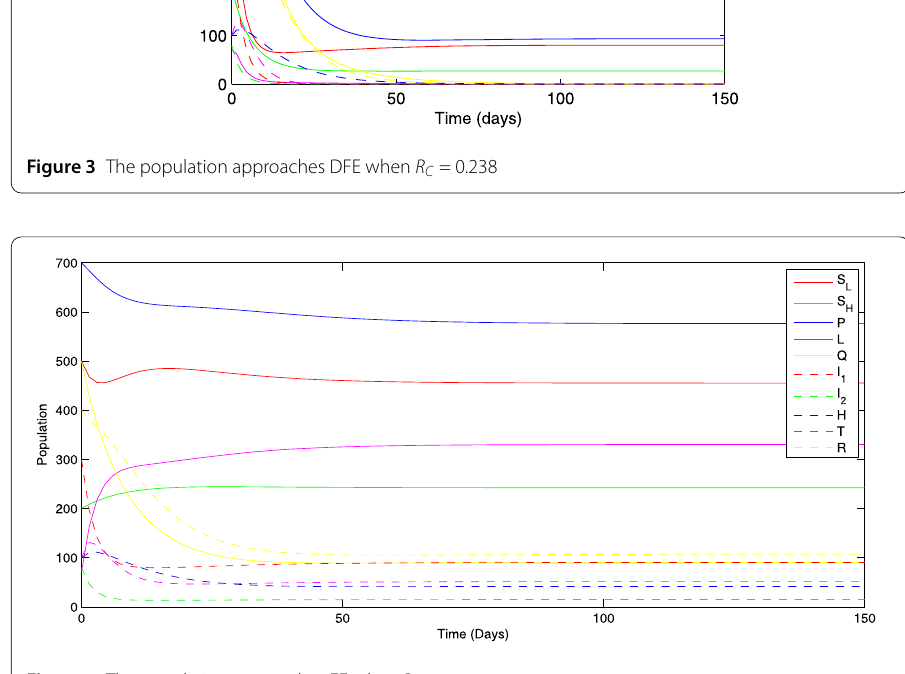
Figure 4 The population approaches EE when R C =